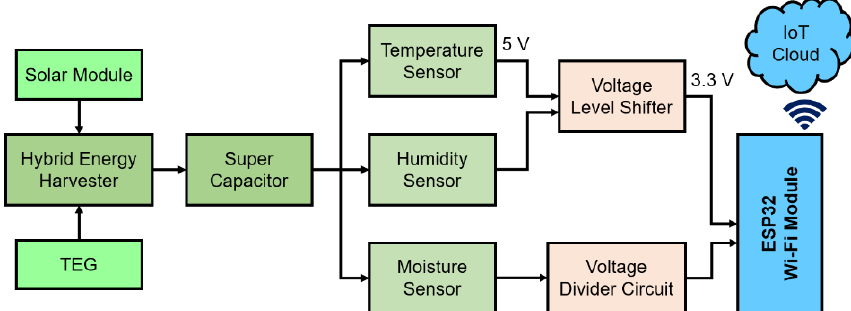
Figure 5. Functional block diagram of the proposed HEH prototype.